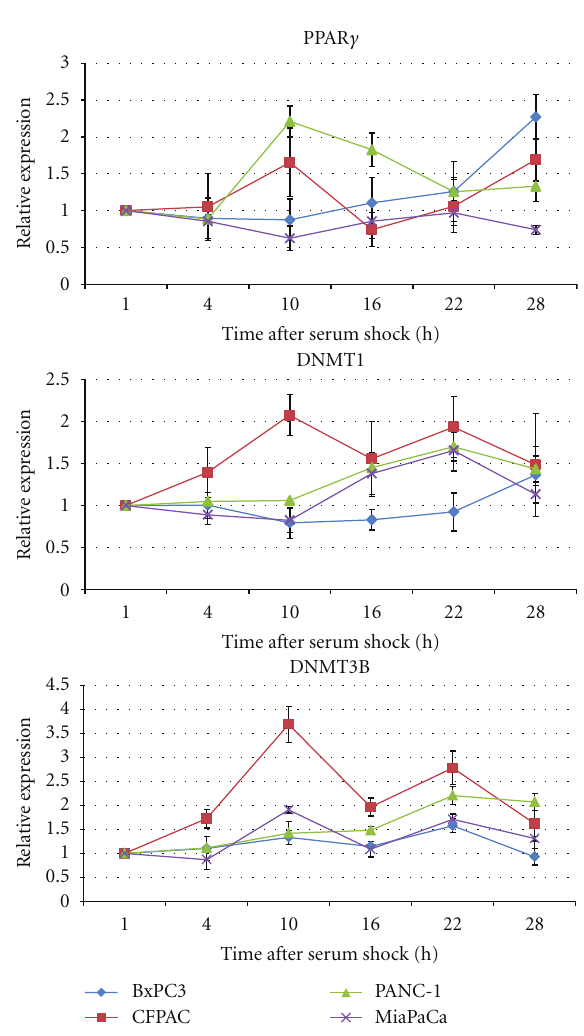
Figure 2: x - y plots showing the time-related profiles of expression level changes of PPARG , DNMT1 , and DNMT3B in pancreatic can- cer cell lines. Original units standardized to T0 and combined for analyses. Gene expression data assigned to actual collection time after serum